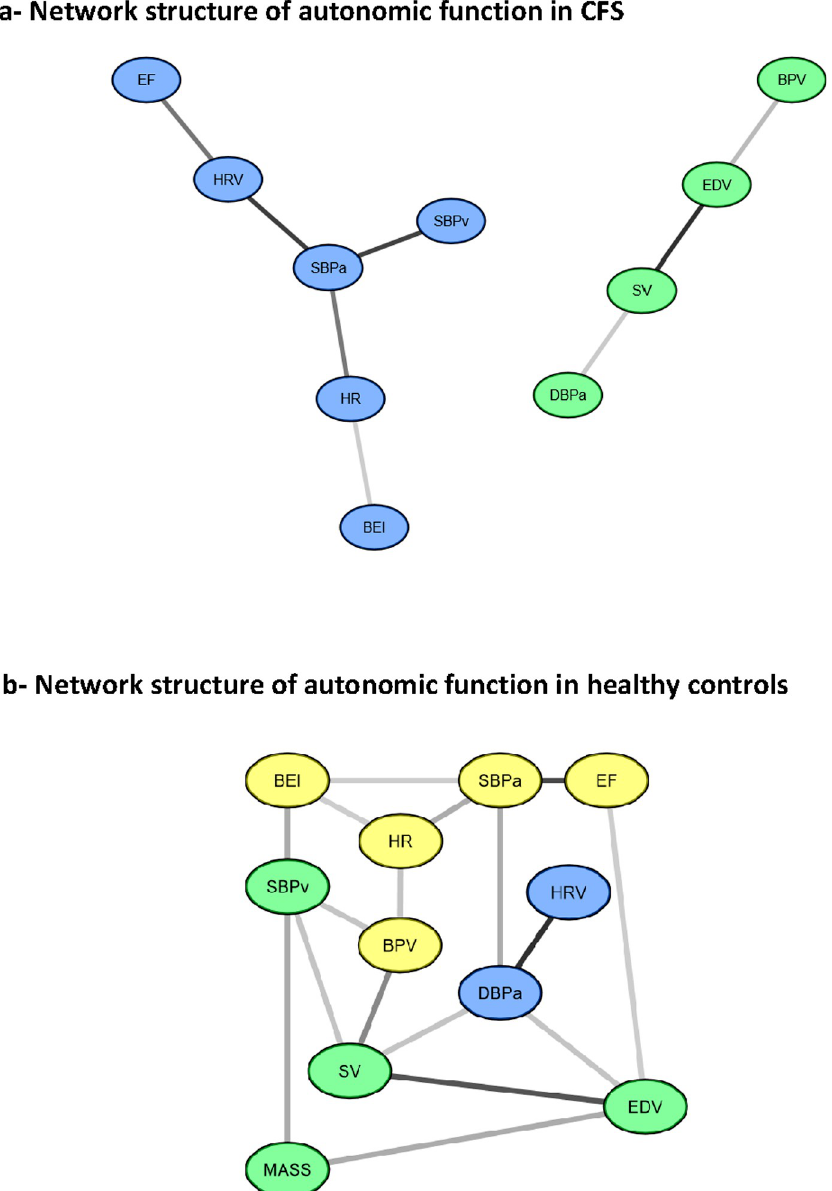
Fig 1. Network structure of autonomic function in a) CFS and b) healthy